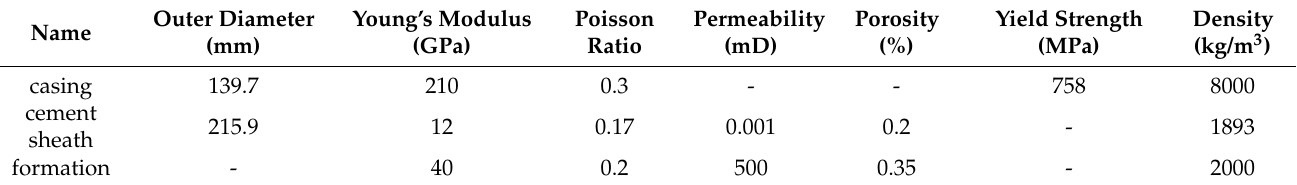
Table 1. Geometric, mechanical, and physical parameters of casing–cement sheath-formation